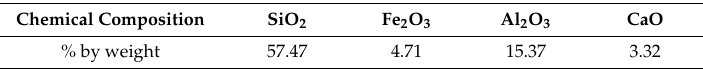
Table 3. Chemical composition of fly ash.